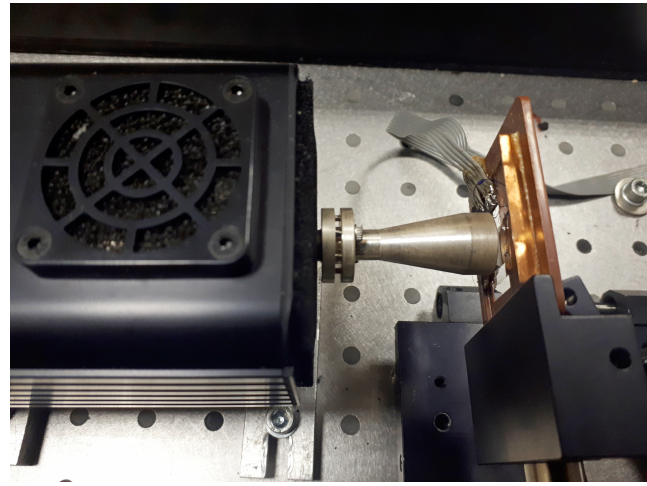
Figure 2. Photo of the experimental setup. The Terasense 140 GHz source of terahertz radiation illuminates the entire area of the sample to which the control devices and parameter reading devices are connected with a